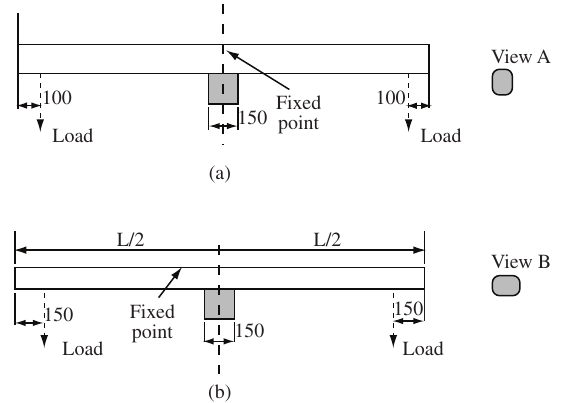
Figure 4. Detail of the bending test: a) View A; and b) View B.